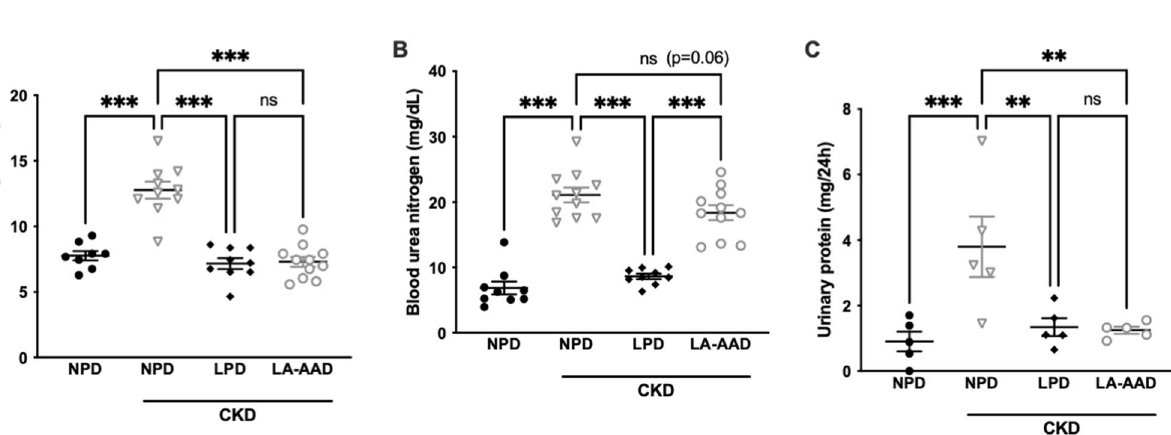
Figure 2. Kidney function and urinary protein excretion in control and CKD mice. Serum creatinine ( A ), blood urea nitrogen ( B ) and urinary proteins ( C ) in control and CKD mice fed with normoproteic diet (NPD), low protein diet (LPD) or low aromatic amino-acid diet (LA-AAD). Data are expressed as mean ± SEM for n = 9–11 animals in each group. Proteinuria was only measured on 5 animals per groups. * p < 0.05, ** p < 0.01, *** p < 0.001 versus CKD-NPD; (ANOVA and Dunnett post hoc